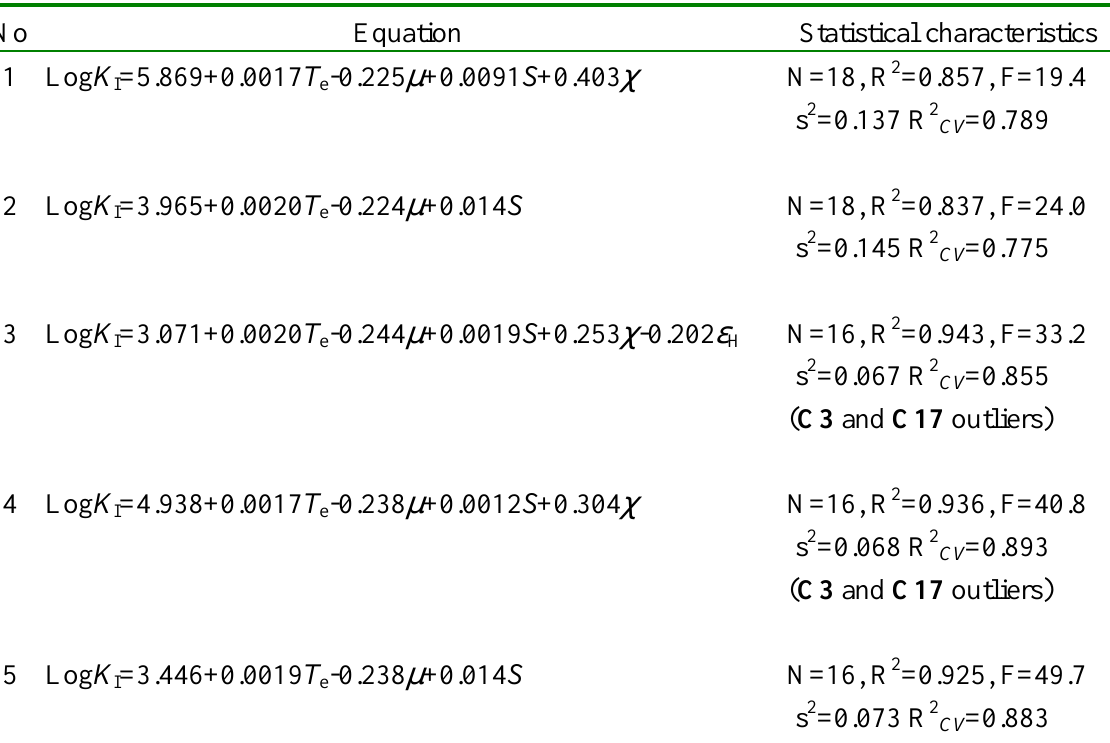
Table 3. Obtained QSAR models for the molecules studied against CA-II